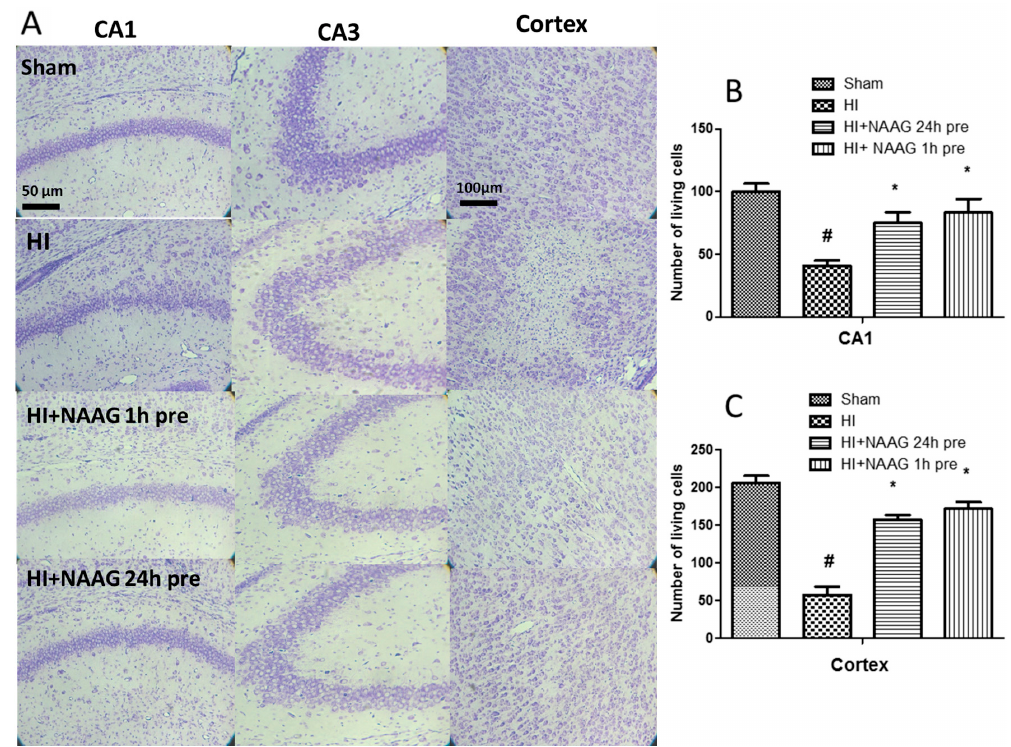
Figure 2. Neuroprotective e ff ect of NAAG application observed in the CA1 and CA3 region of the hippocampus and the cerebral cortex of the ipsilateral hemisphere 7 days after HI ( A ). Quantification of surviving neurons in ( B ) the central part of the CA1 region (100 µ m in length) and ( C ) cortex (250 µ m × 250 µ m area). NAAG was applied i.p. 24 h or 1 h before HI. The microphotographs show the ipsilateral hemisphere. # p < 0.005 compared to sham operated group; * p < 0.05 compared to HI group.